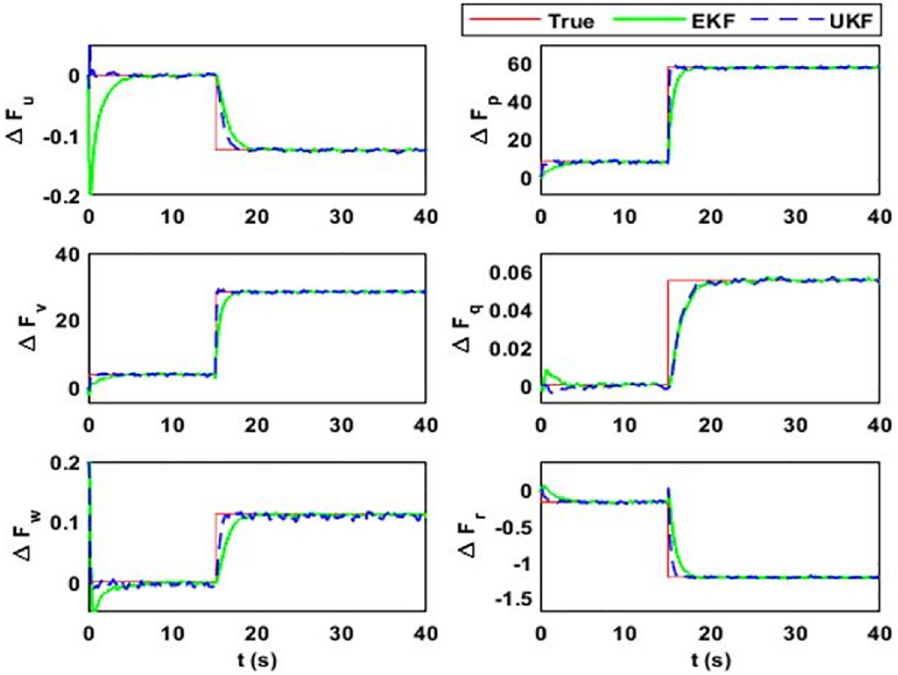
Fig 5. Estimation of model uncertainty and disturbance vector. In this case, it estimates the total effect on airship body axes linear and angular acceleration due to the variations that occur in the airship aerodynamic model: (i) Δ F (ii) Δ F p ; (iii) Δ F v ; (iv) Δ F q ; (v) Δ F w ; (vi) Δ F r